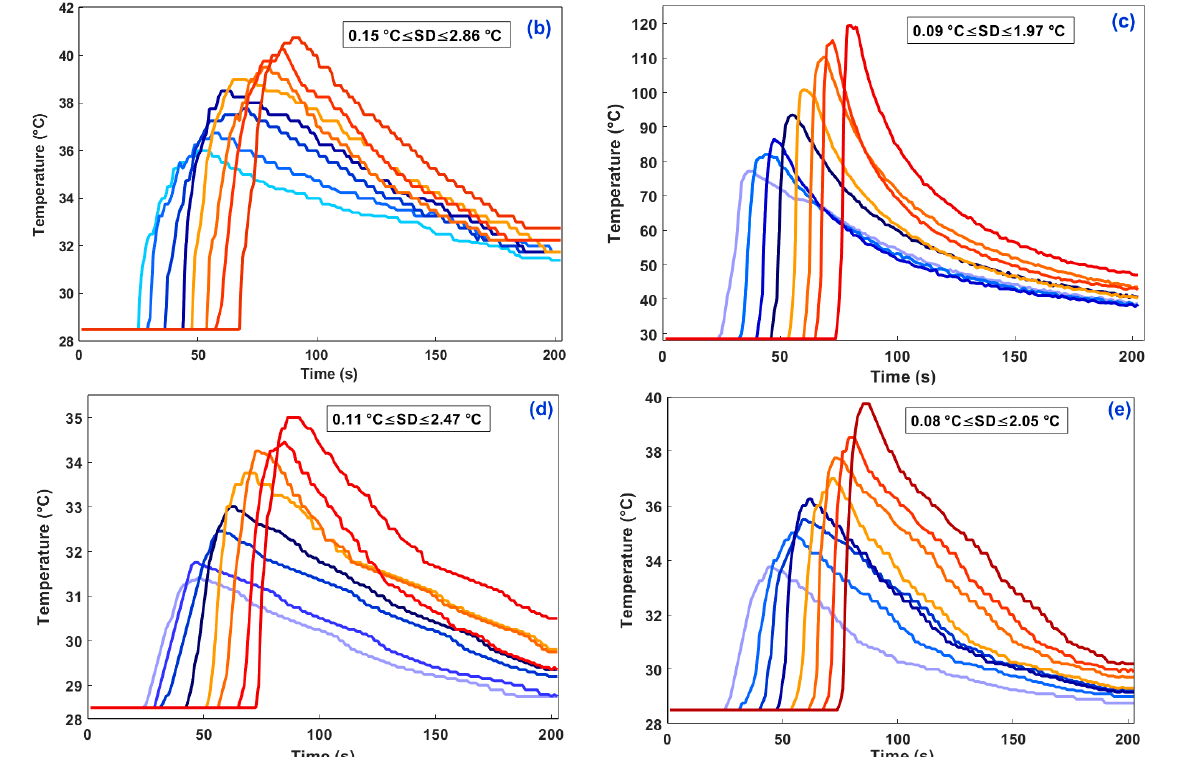
Figure 3. Temperature measurements during machining of the GFRP specimens at a feed rate of 50 mm/min: ( a ) Pure Epoxy matrix, ( b ) 0° GFRP, ( c ) 90° GFRP, ( d ) 0°/silica sand filled GFRP, ( e ) 90°/silica sand filled GFRP. Table 5. Summary of sampling points heating rates ( ◦ C · s − 1 ) and thermal diffusion distances (mm) along the manifesting